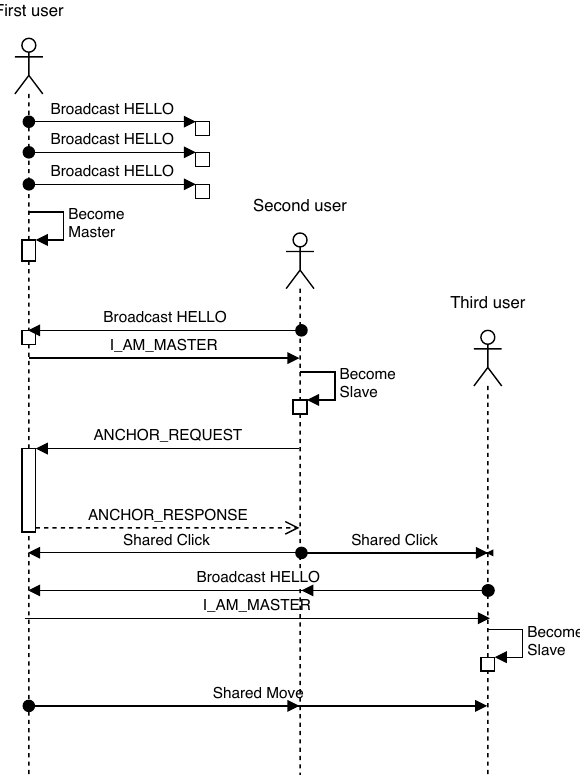
Figure 5. Flow diagram of a simple message